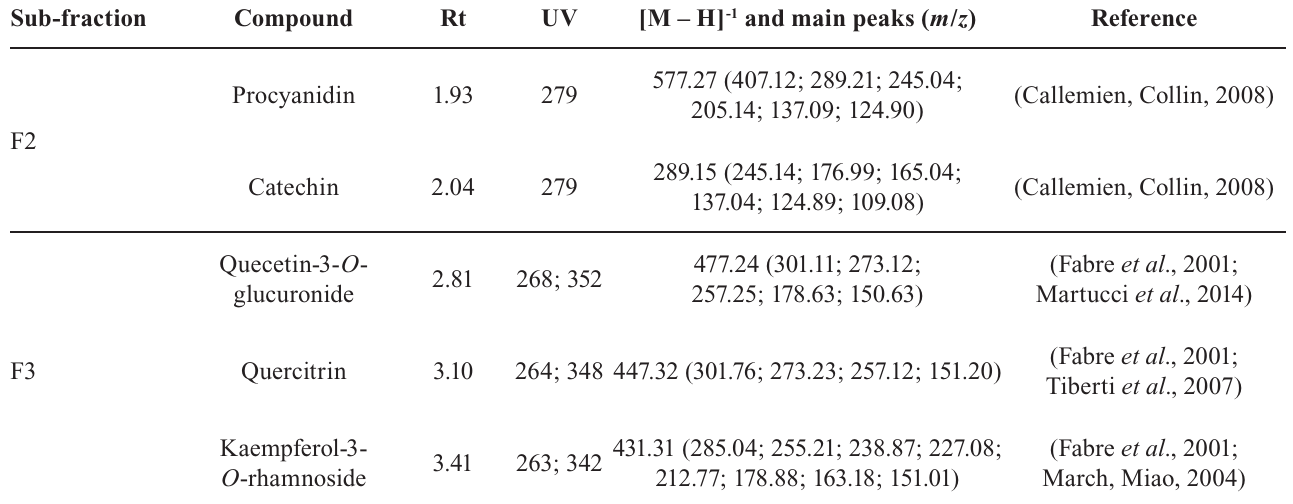
TABLE II - Compounds identified by means of UV and LC-DAD-ESI/MS analysis of sub-fraction F2 and F3 from hydromethanolic fraction of P. spruceanum